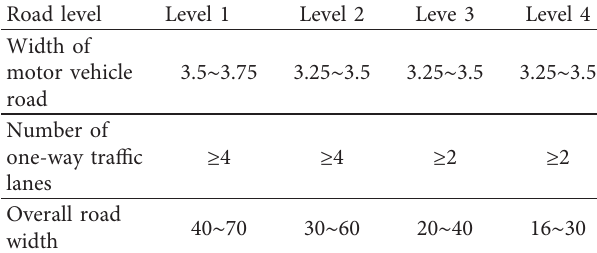
Table 5: Each level of road corresponding to the road width and maximum capacity table.